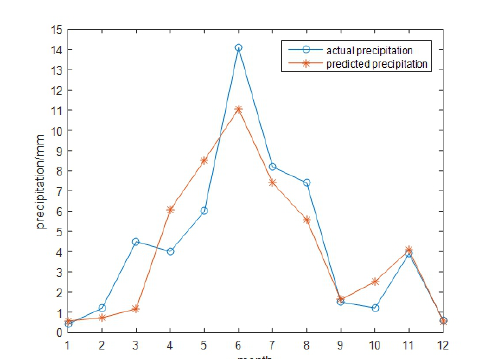
Figure 7. Figure linear regression model seasonal prediction of precipitation changes in